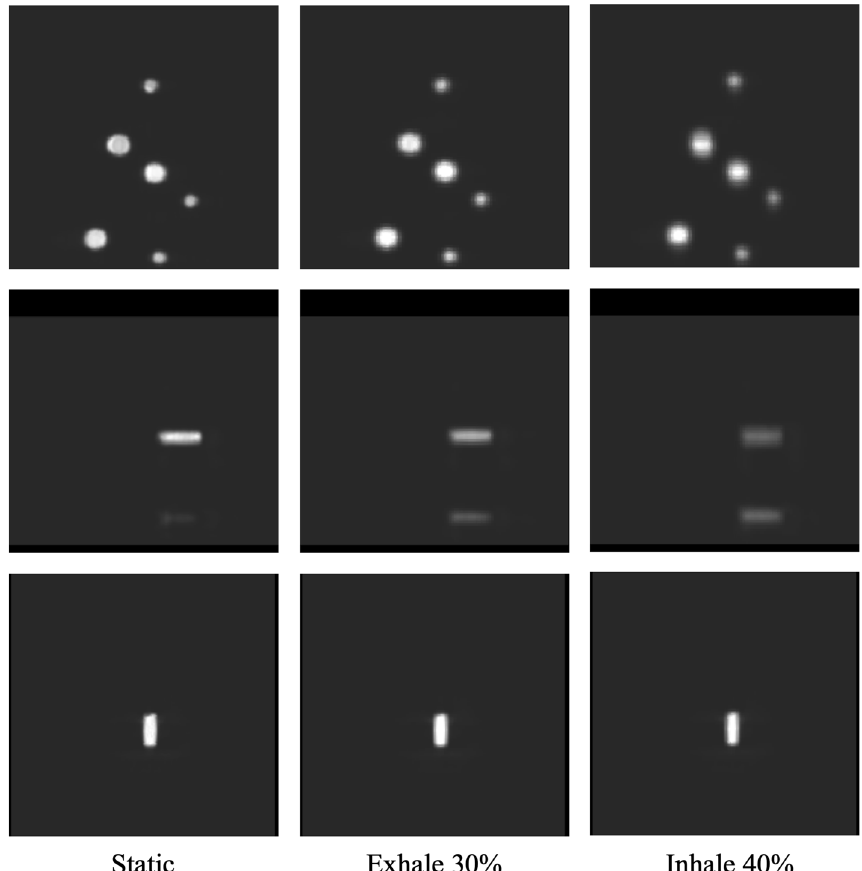
Fig. 12 Coronal, axial and sagittal PET images for reference static protocol, Exhale 30% protocol and Inhale 40% protocol of the CIRS